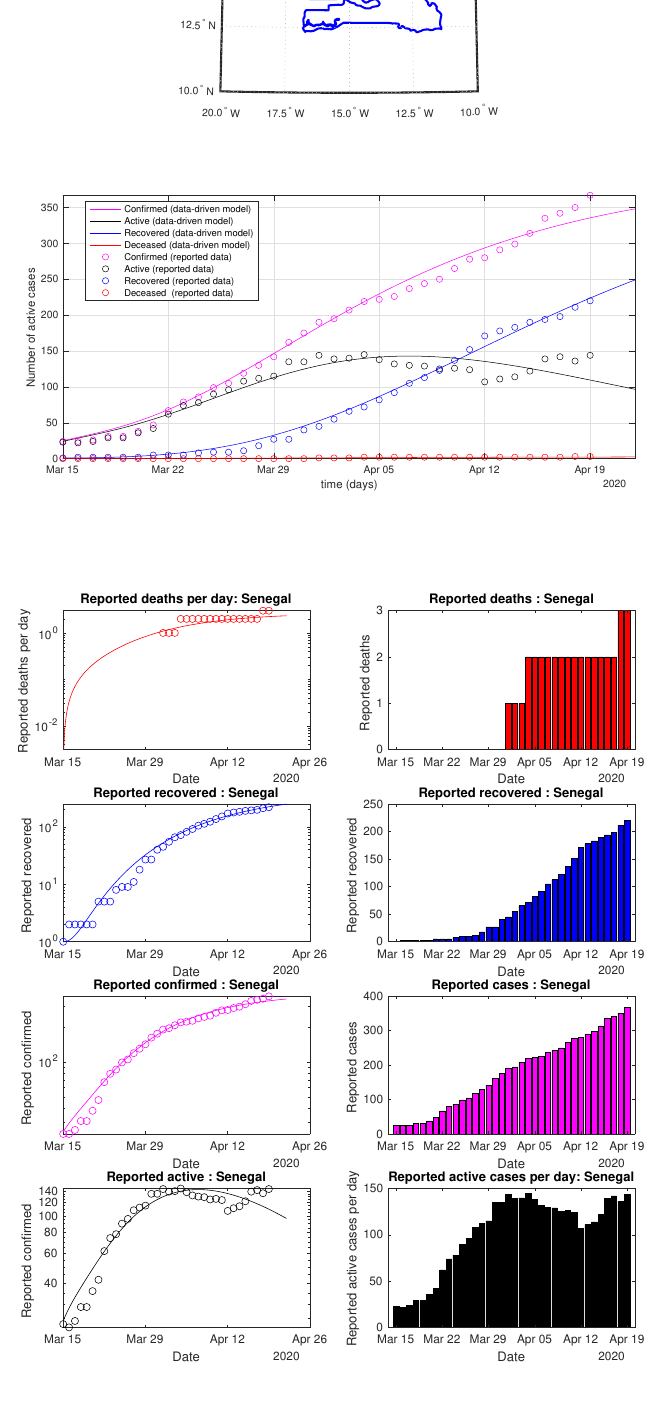
Figure 81. Senegal: data vs.